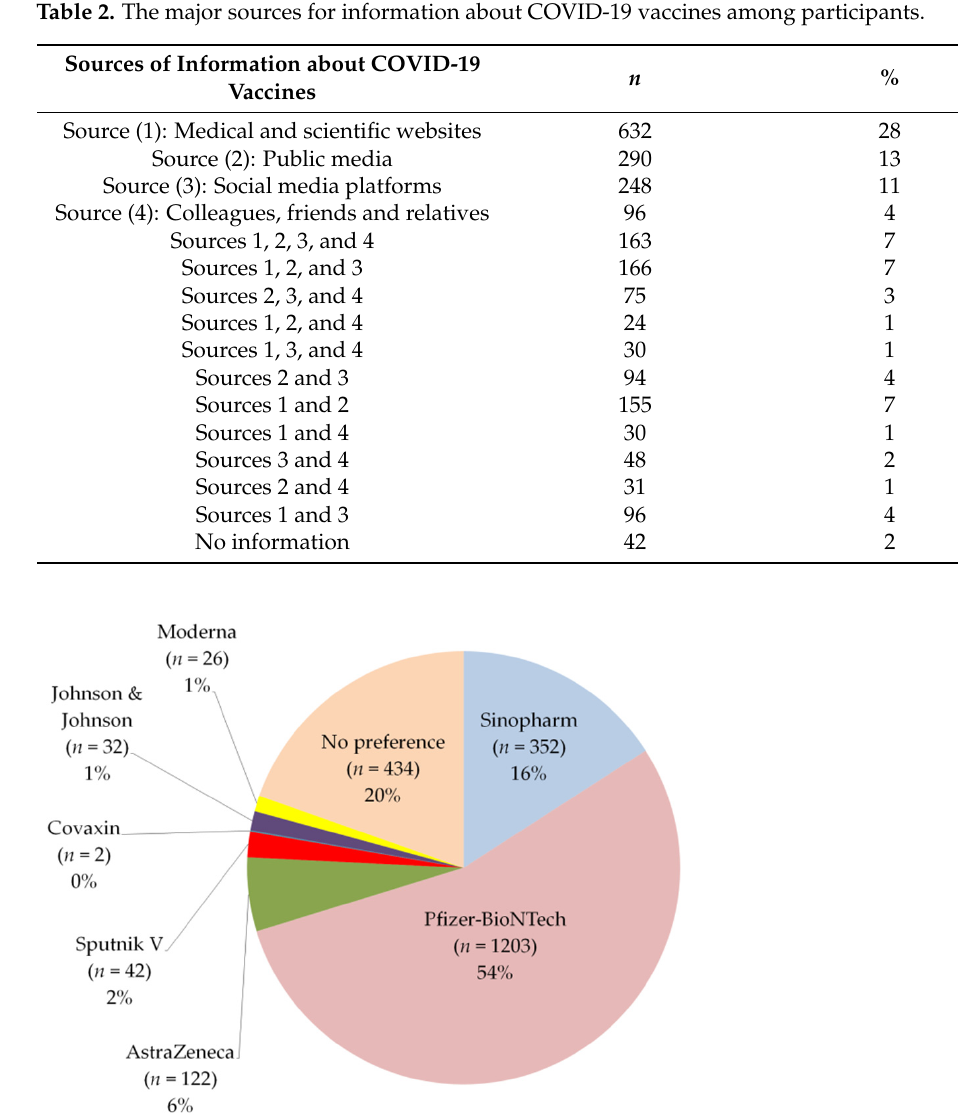
Figure 1. Frequencies of vaccines preferred by participants. Furthermore, more than half of participants reported that they were initially scared from the side effects of COVID-19 vaccines. About 32% of the participants are suffering from chronic diseases, 18% were previously infected with COVID-19, 38% are smokers, and less than 7% have food and drug allergies (Figure